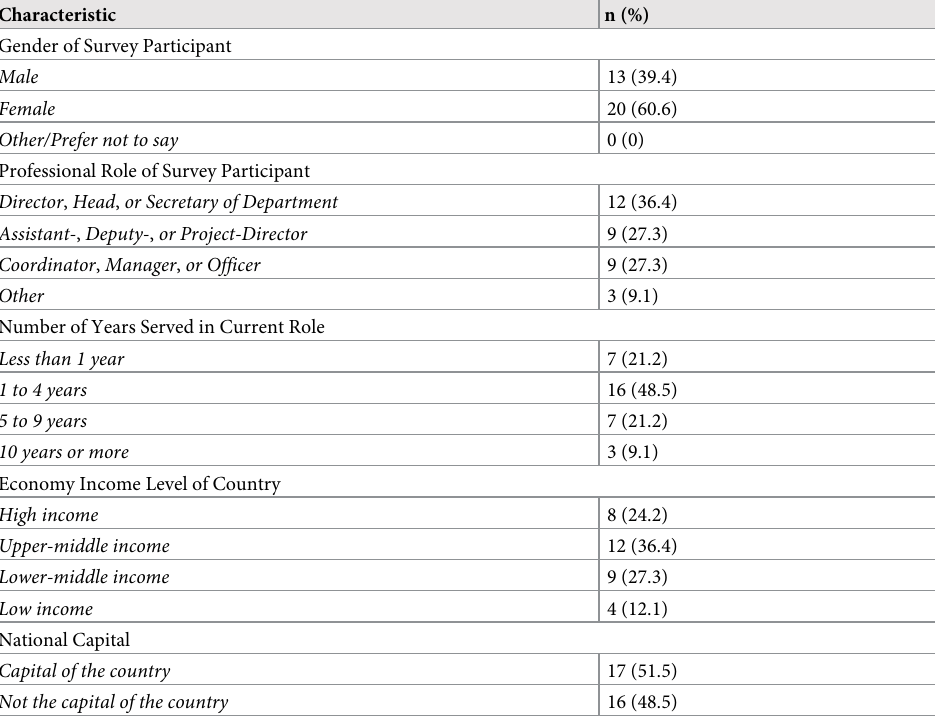
Table 1. Characteristics of survey participants and cities (n =